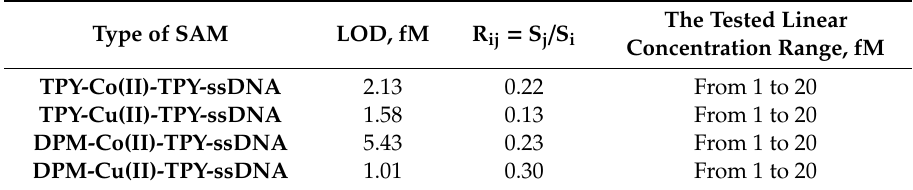
Figure 4. Representative Osteryoung square-wave voltammograms obtained for the gold electrode modified with: ( A ) DPM / Co(II) / TPY / ssDNA and ( B ) DPM / Cu(II) / TPY / ssDNA after hybridization with 20-mer complementary (c-NC3) and non-complementary (nc-NC3) ssDNA target at concentrations of 0 (dashed curve), 1, 5, 10, 15 and 20 fM. Bu ff er conditions: PBS, pH 7.4. Table 5. Comparison of detection limits (LOD), selectivity ( R ij ) of presented systems and the tested linear concentration